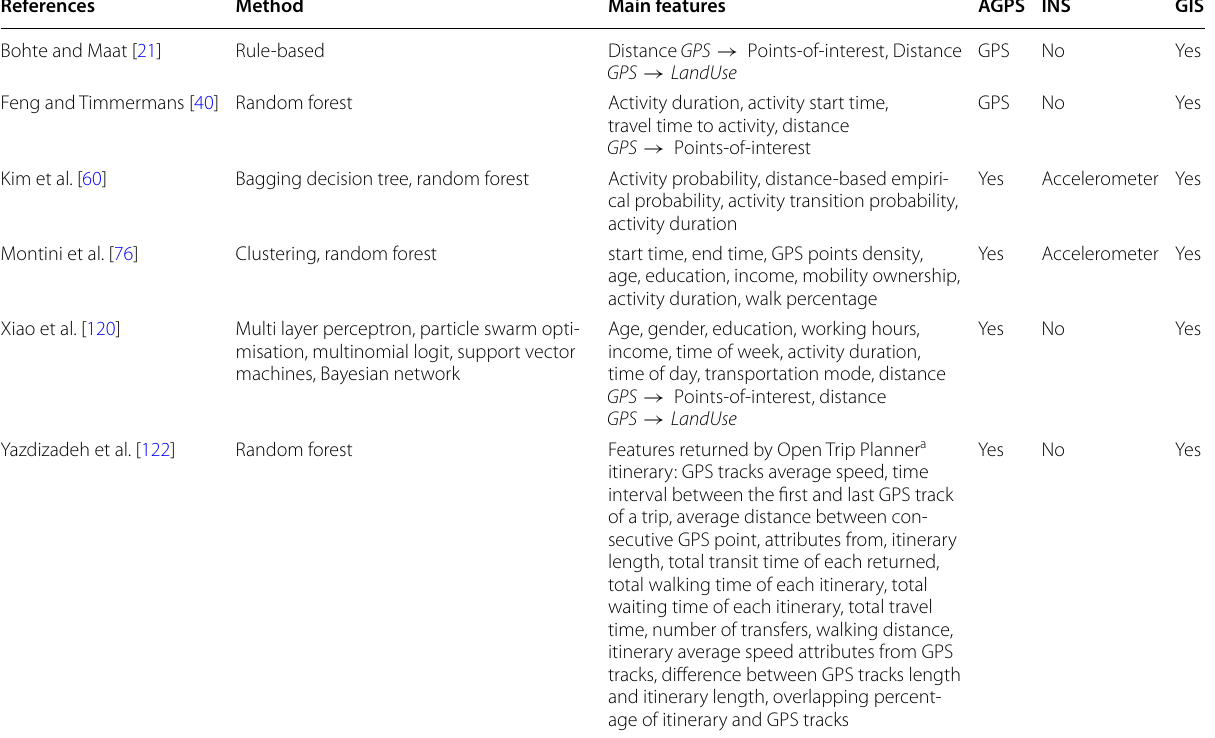
Table 6 Methodlogy and features, for purpose